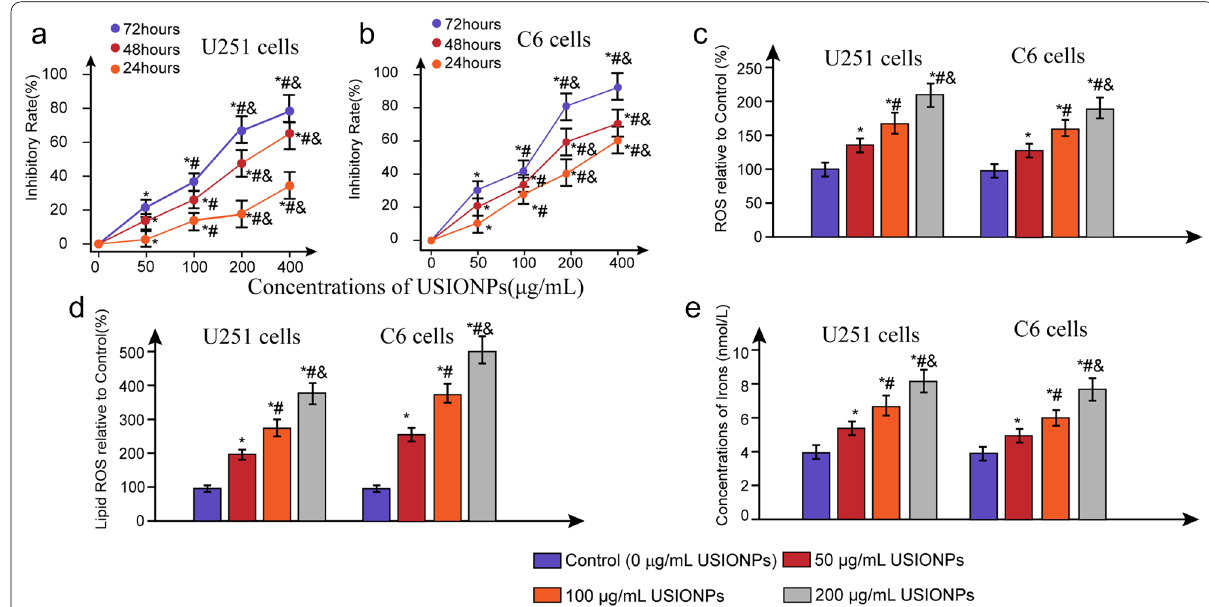
Fig. 3 Effect of USIONPs on the cell inhibitory rates, intracellular ROS, concentrations of iron and ferroptosis in GBM cells. a Inhibitory rates of U251 cells treated with different concentrations of USIONPs for 24, 48, and 72 h; b Inhibitory rates of C6 cells treated with different concentrations of USIONPs for 24, 48, and 72 h; c Relative ROS levels in U251 cells and C6 cells treated with different concentrations of USIONPs for 48 h; d Relative lipid ROS levels in U251 cells and C6 cells treated with different concentrations of USIONPs for 48 h; e Iron concentrations in U251 cells and C6 cells treated with different concentrations of USIONPs for 48 h. * P < 0.05, statistically significant compared with control group. # P < 0.05, statistically significant compared with 50 μg/mL USIONPs. & P < 0.05, statistically significant compared with 100 μg/mL